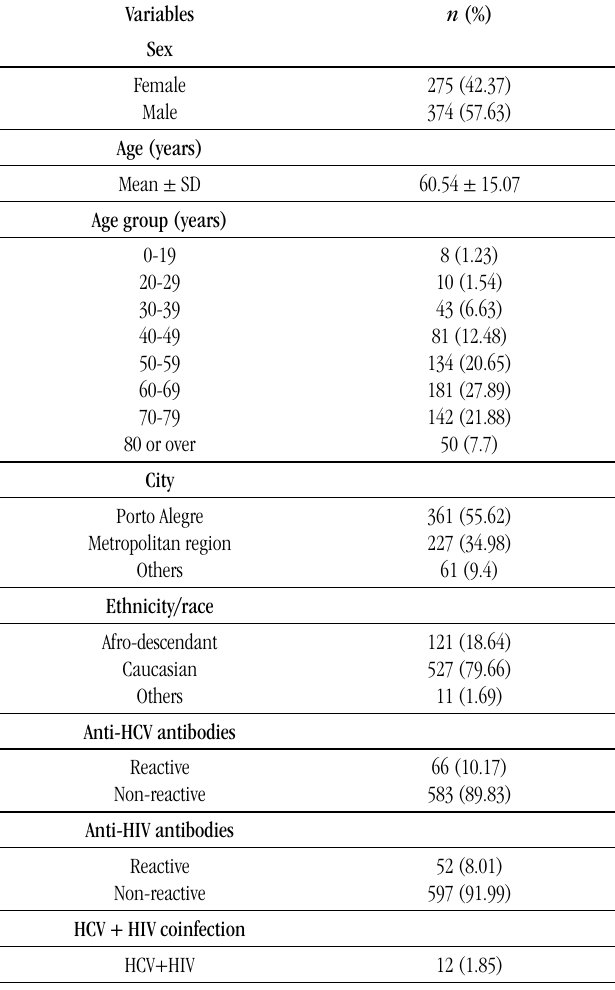
tABLE 1 – Absolute and relative distribution by sex, age group, city, color, mean and SD of age, HCV infection, HIV infection and HCV/HIV coinfection for the group of 649 patients